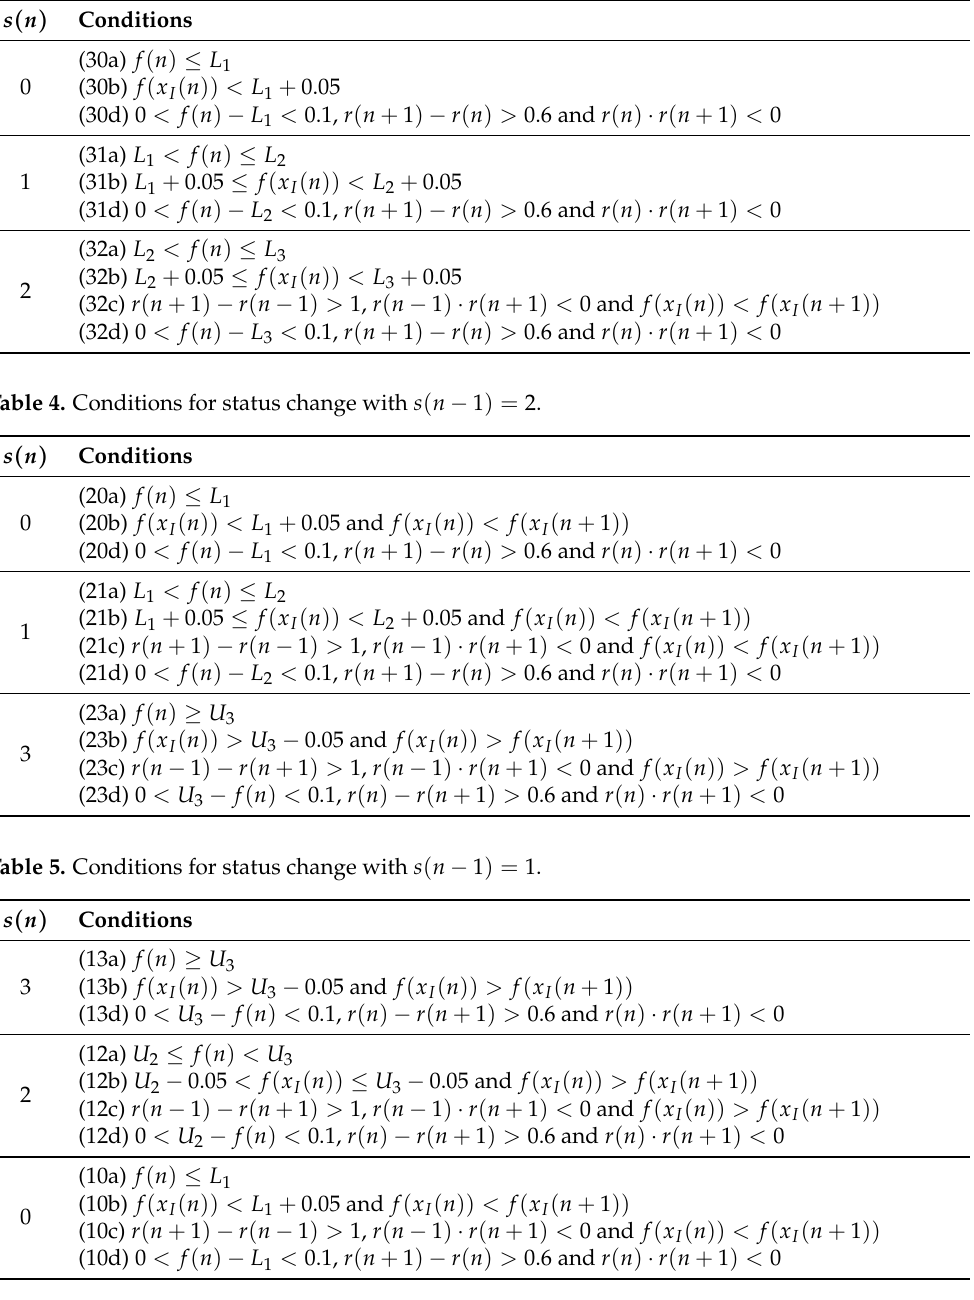
Table 3. Conditions for status change with s ( n − 1 ) = 3.